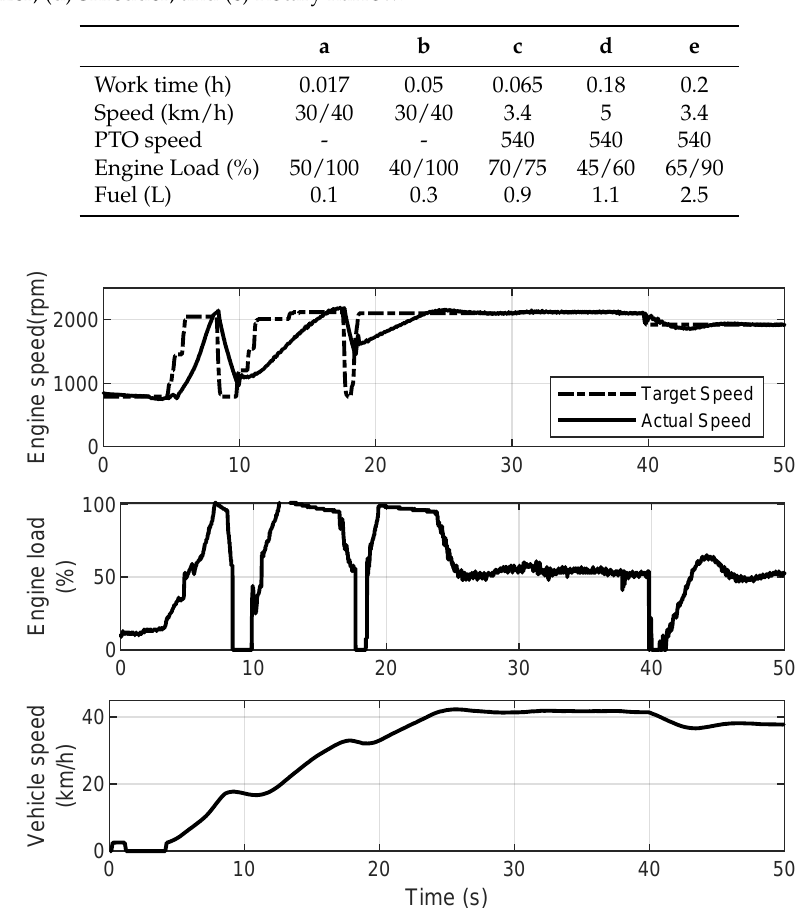
Figure 1. Acceleration test—fully loaded trailer 6000